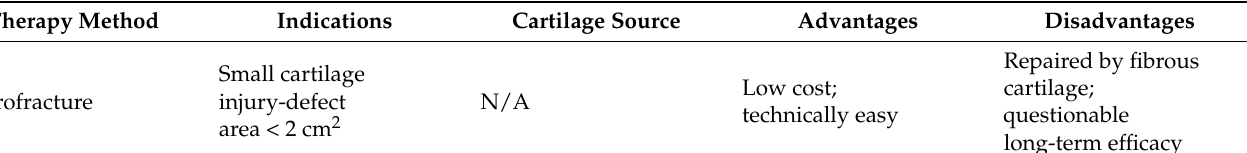
Table 1. Comparison of different surgical therapy methods for cartilage